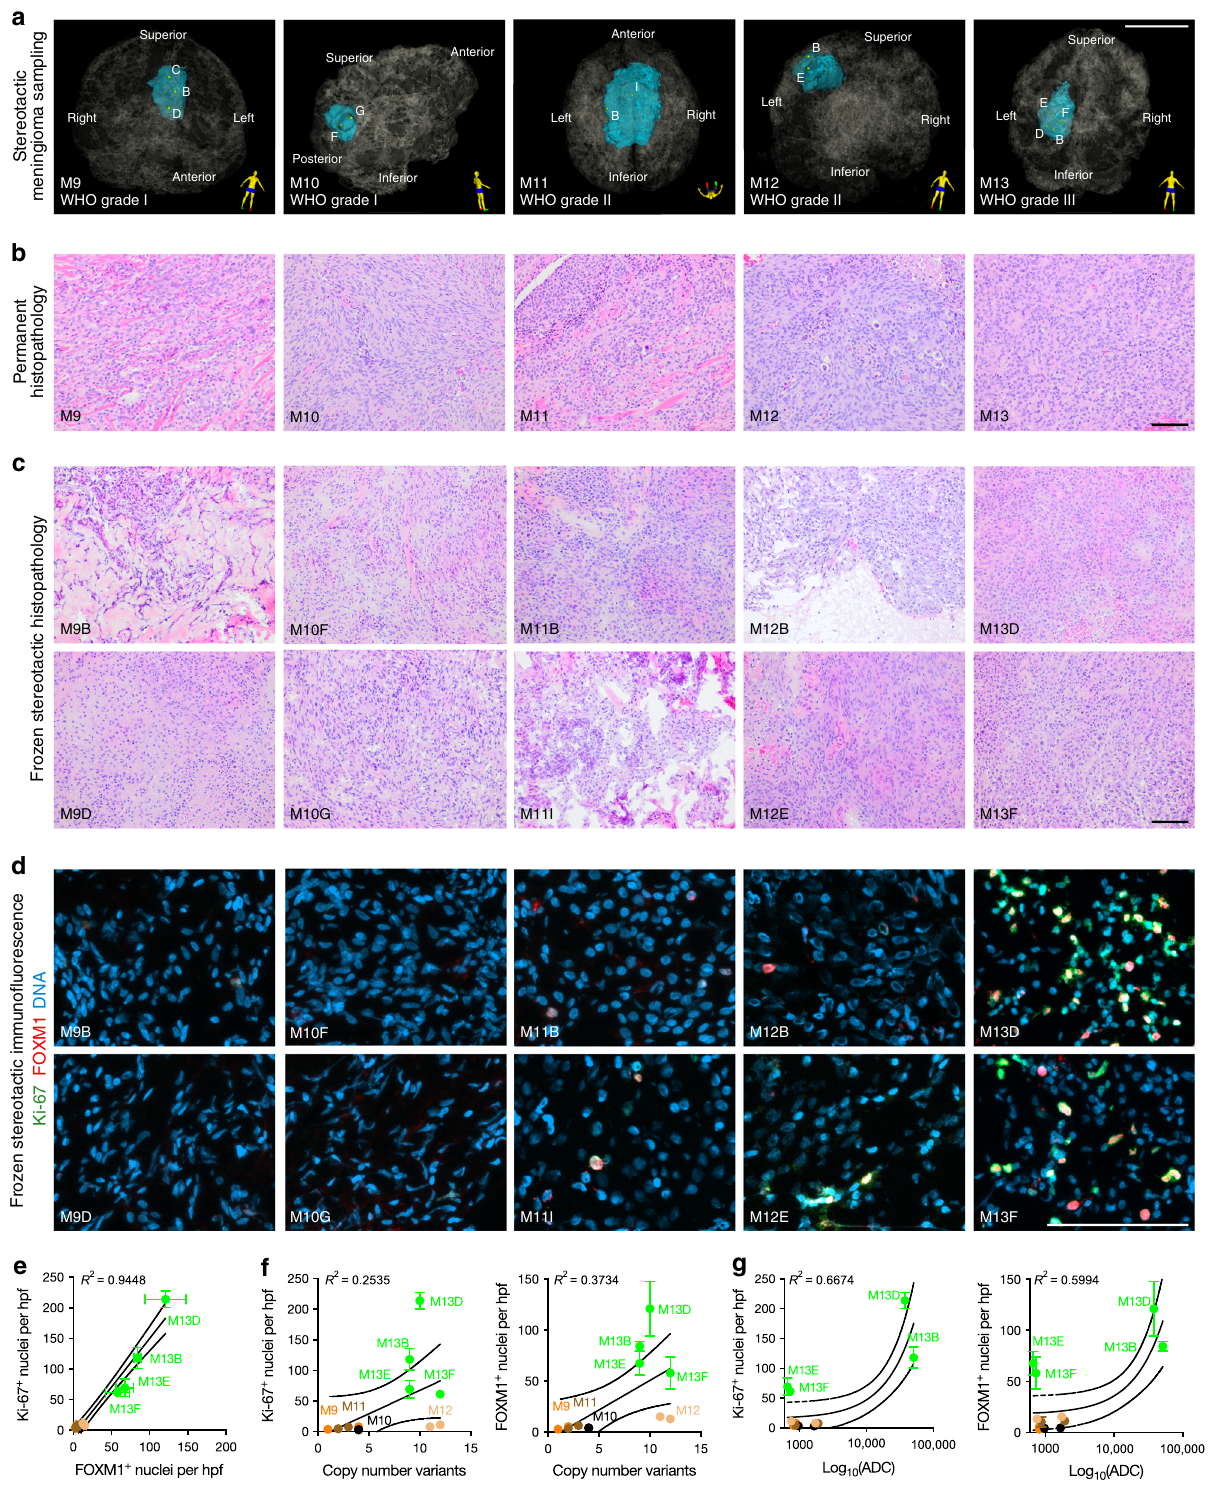
Fig. 4 Intratumor CNVs and radiographic heterogeneity are associated with alterations in meningioma histology. a 3D stereotactic meningioma sampling maps reconstructed from preoperative MR imaging. Patient orientation is represented by the model on the bottom right of each panel. Scale bar, 5 cm. b , c Comparison of permanent surgical histopathology and frozen stereotactic histology from spatially distinct samples reveals intratumor and intertumor heterogeneity in meningioma. Scale bars, 100 μ m. d , e Quantitative immuno fl uorescence for Ki-67 (green) and FOXM1 (red) demonstrates a strong positive association and elevated cell proliferation in high grade meningiomas, with heterogeneity among spatially distinct samples from individual tumors. DNA is marked with DAPI (blue). Scale bars, 100 μ m. f , g Ki-67 and FOXM1 immuno fl uorescence demonstrate a positive association with the number of CNVs and the ADC value of each spatially distinct meningioma sample. Mean ± standard error of the mean (as shown by error bars) are denoted for each scatter plot ( e – g ). Samples from spatially distinct meningioma samples are color-coordinated by